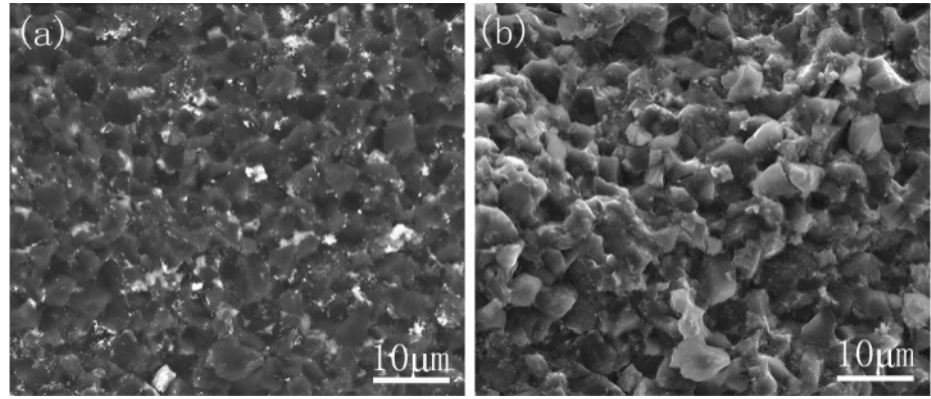
Figure 9. Three-point bending fracture of the cBN composite (5 μ m): ( a ) BSED and ( b ) ETD. To further illustrate the influences of binder particle size and grain size on the flexural strength of the composite, the XRD patterns of the TiAl powder before and after ball milling (Figure 2) were peak fitted. The grain size (D) was calculated by the Scherrer formula.